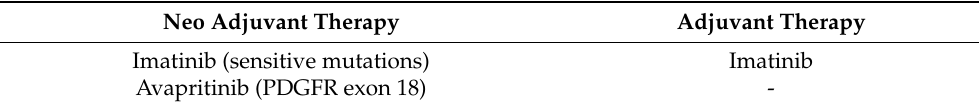
Table 1. Systemic Therapy for Resectable Gastrointestinal Stromal Tumors (GISTs) (NCCN Guidelines V.1.2021).